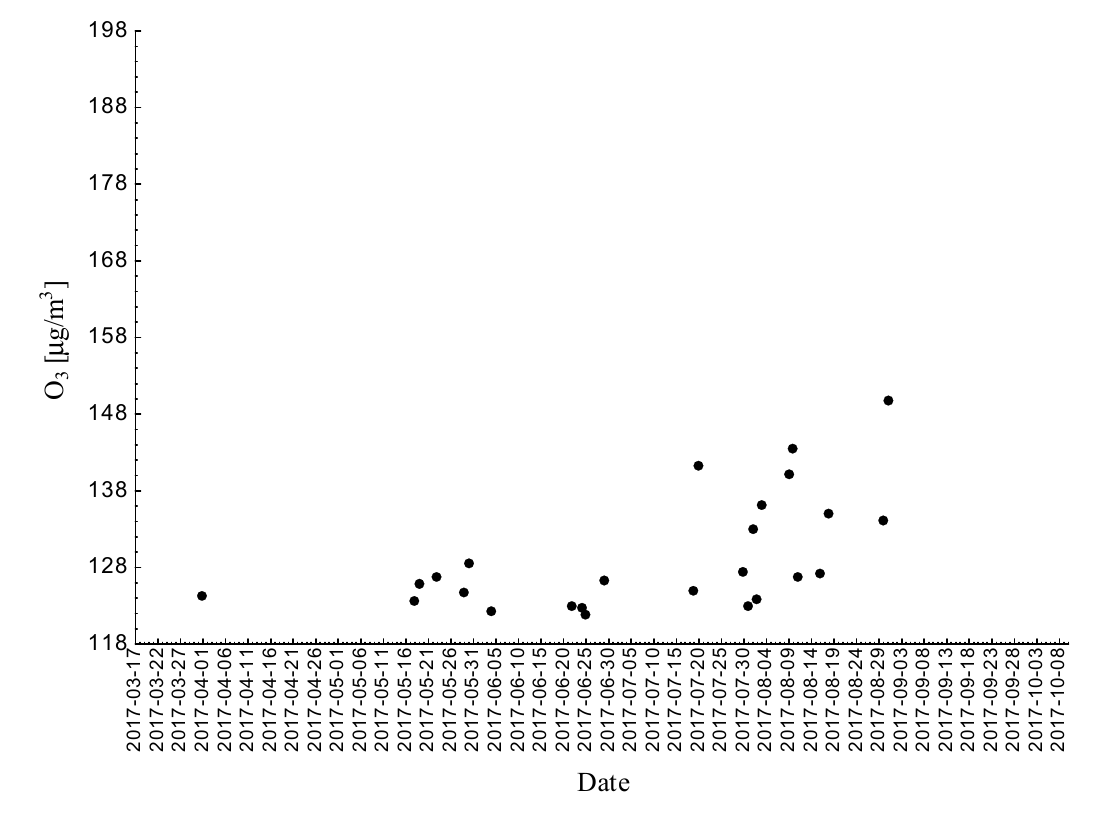
Figure 10. Maximum daily 8-h mean ozone concentration not less (equal to or more than) than 120.4 µg/m registered at the measurement station in Zloty Potok SL03ZP in 2017.